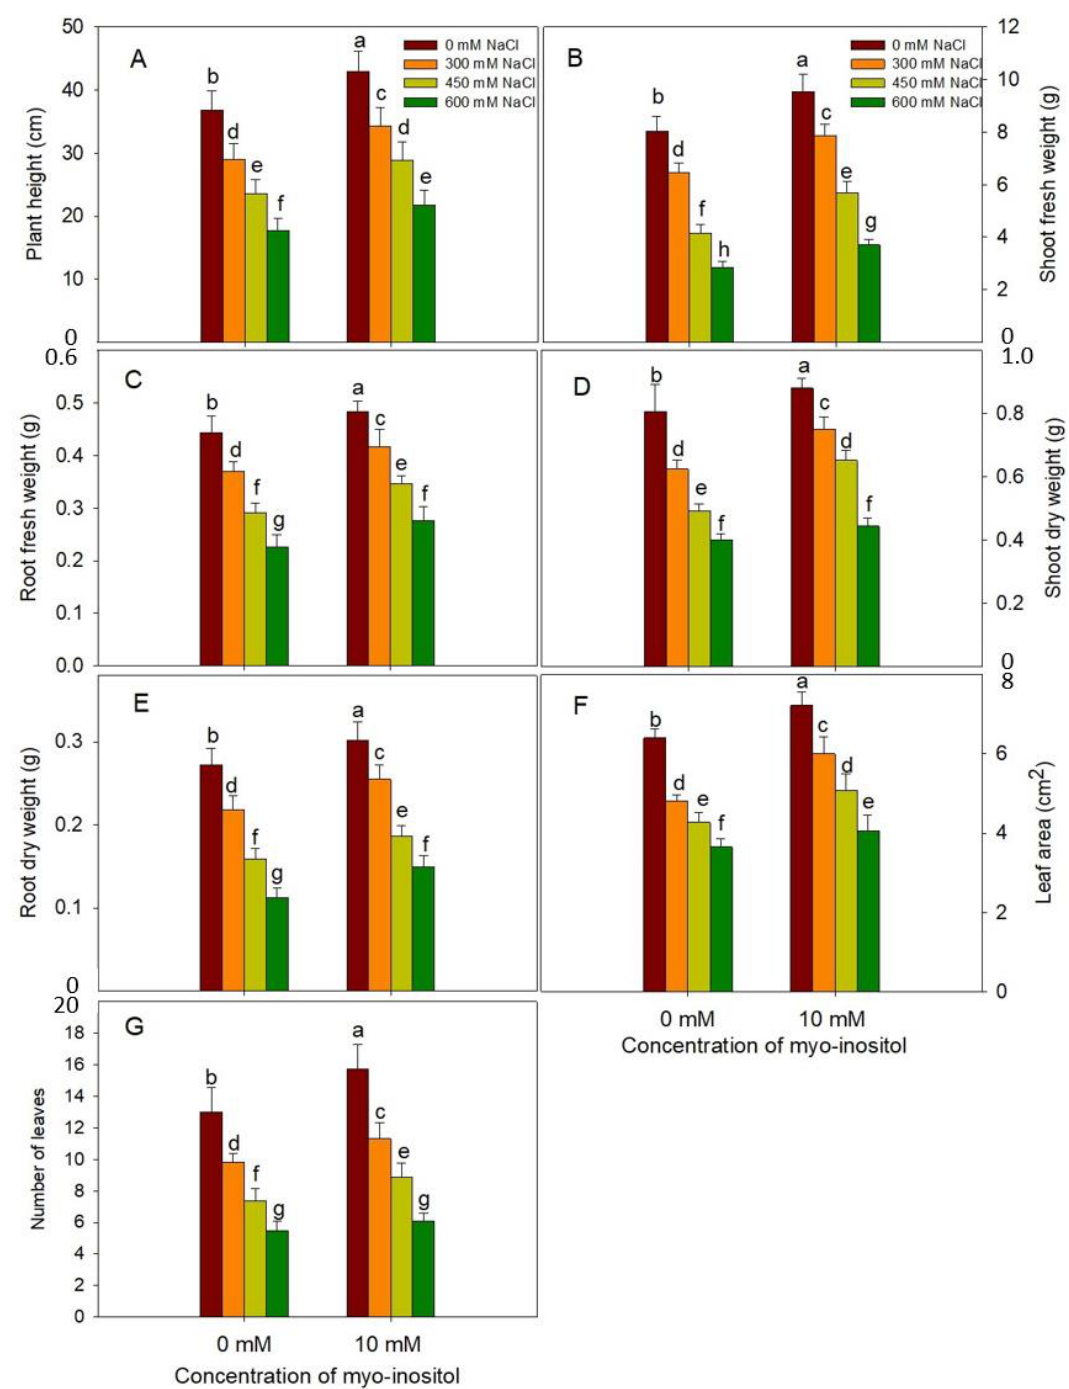
Figure 1. Effect of different salinity (300, 450, and 600 mM NaCl) concentrations with and without exogenous application of myo-inositol (10 mM) on growth parameters in Quinoa ( Chenopodium quinoa L. var. Giza1). Data were expressed as ( A ) plant height (cm); ( B ) fresh shoot weight; ( C ) fresh root weight; ( D ) dry shoot weight; ( E ) dry root weight; ( F ) leaf area (cm 2 ) and ( G ) leaf number. Values are mean (±SE) of four replicates, and different letters represent significant differences at p ≤ 0.05.